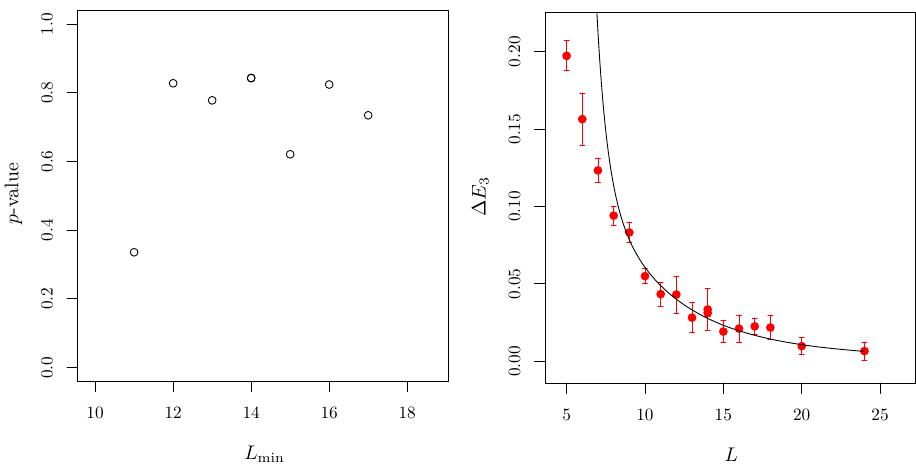
Fig. 8 Left: p value as a function of L min for the fits of Eq. (21) up to order L − 5 to our data for (cid:7) E 3 , i.e. with a the only fit parameter. Right: exemplary plot of a fit (solid line) of Eq. (21) to the data for (cid:7) E 3 with L min = 9 and L max =